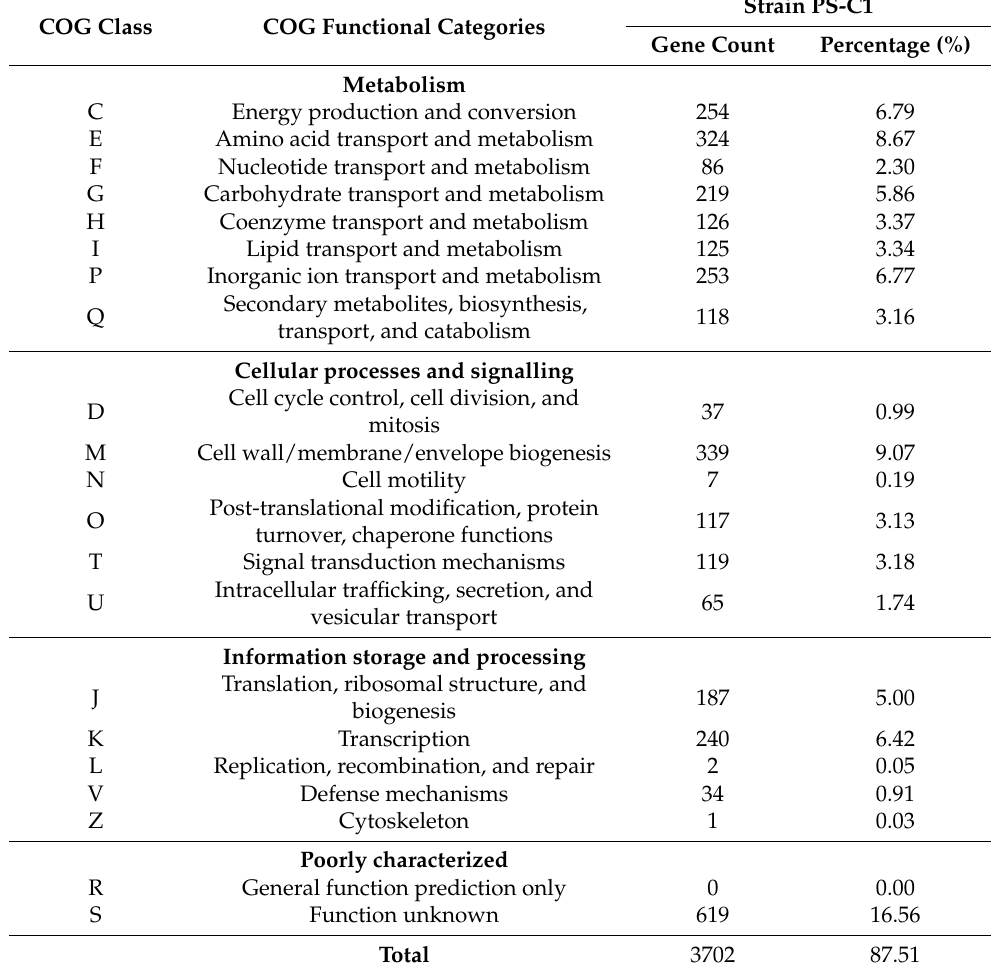
Table 4. Cluster of Orthologous Group (COG) functional assignments of strain PS-C1 a . COG